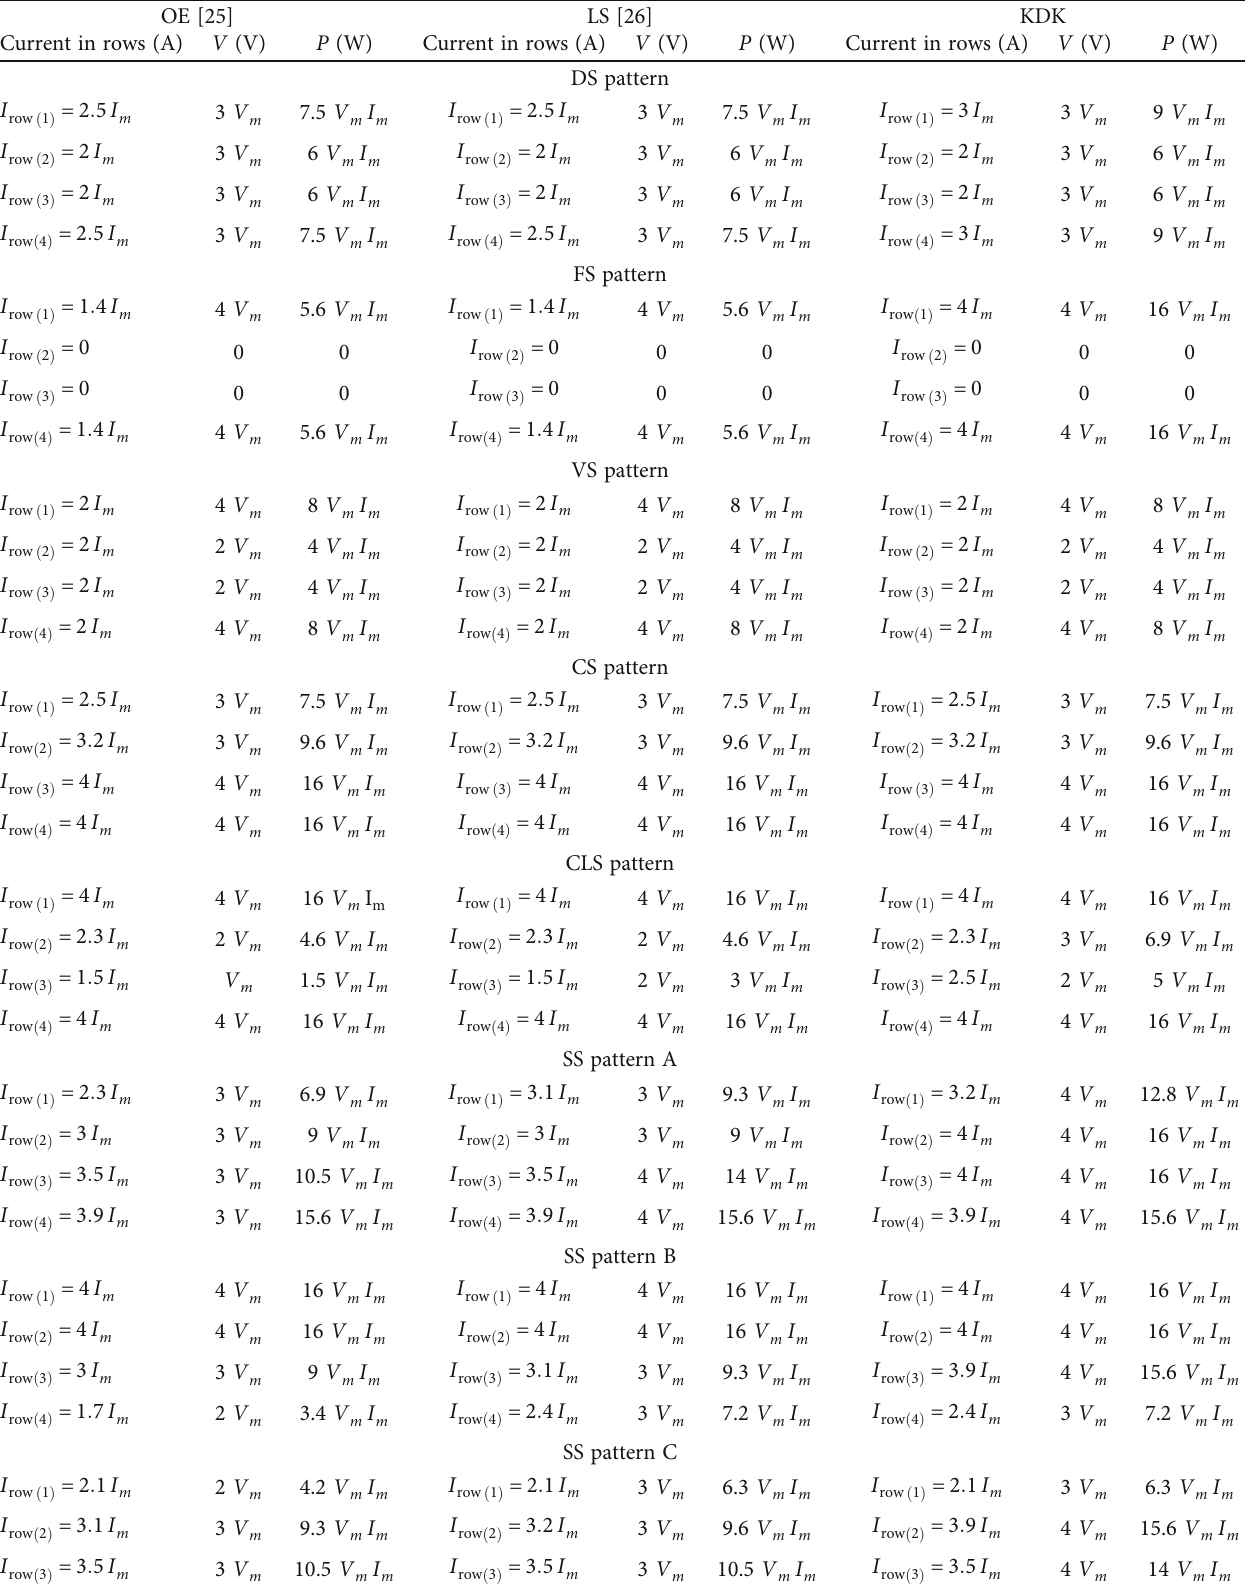
Table 2: Maximum power estimation for OE [25], LS [26], and KDK arrangement schemes of con fi guration under di ff erent partial shading